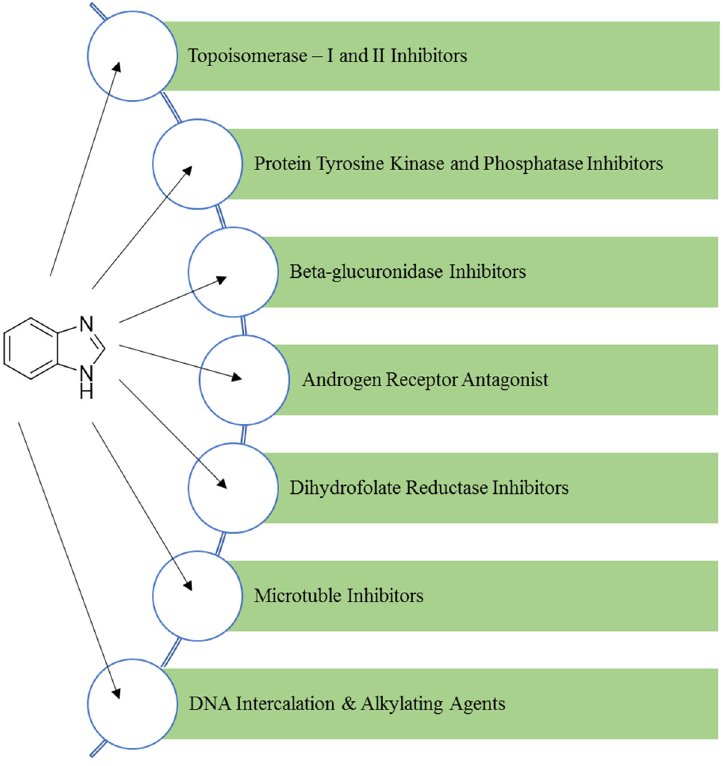
Figure 4. Various biological targets for benzimidazole.